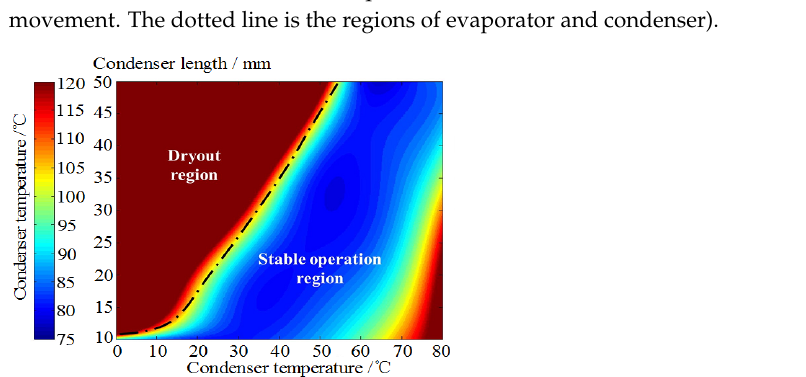
Table 3. Effect of OHP pipeline structure on performance.